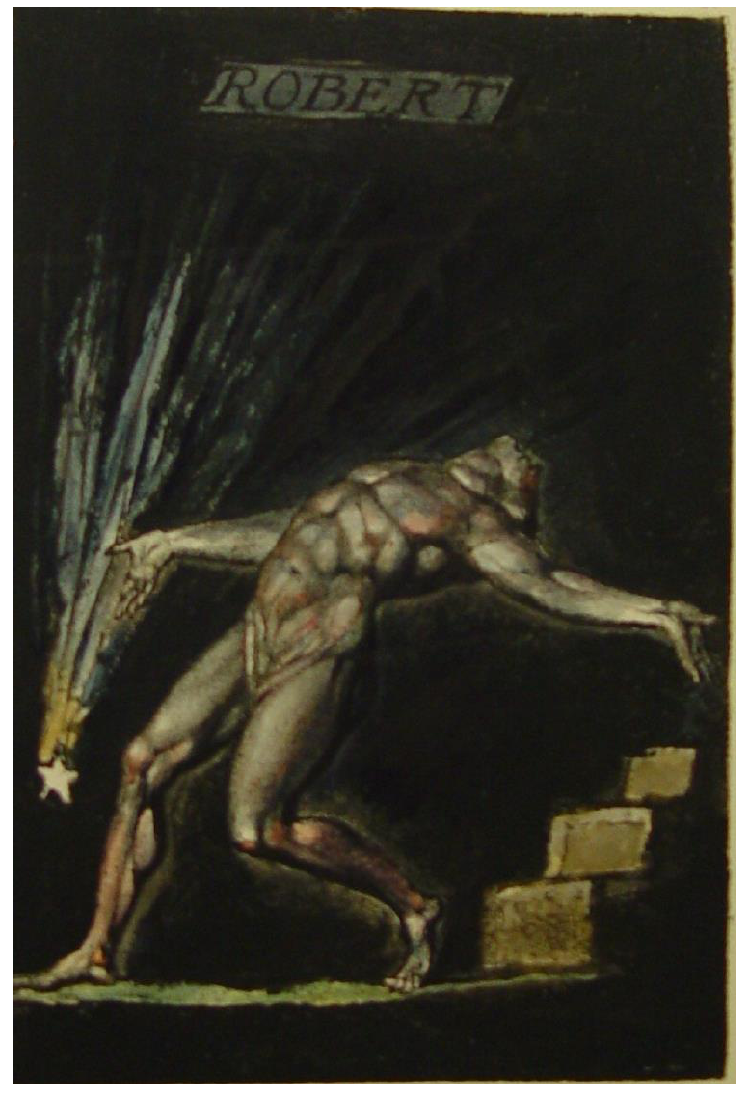
Figure 3. Milton: A Poem , Copy A, Plate 33 © The Trustees of the British Museum.